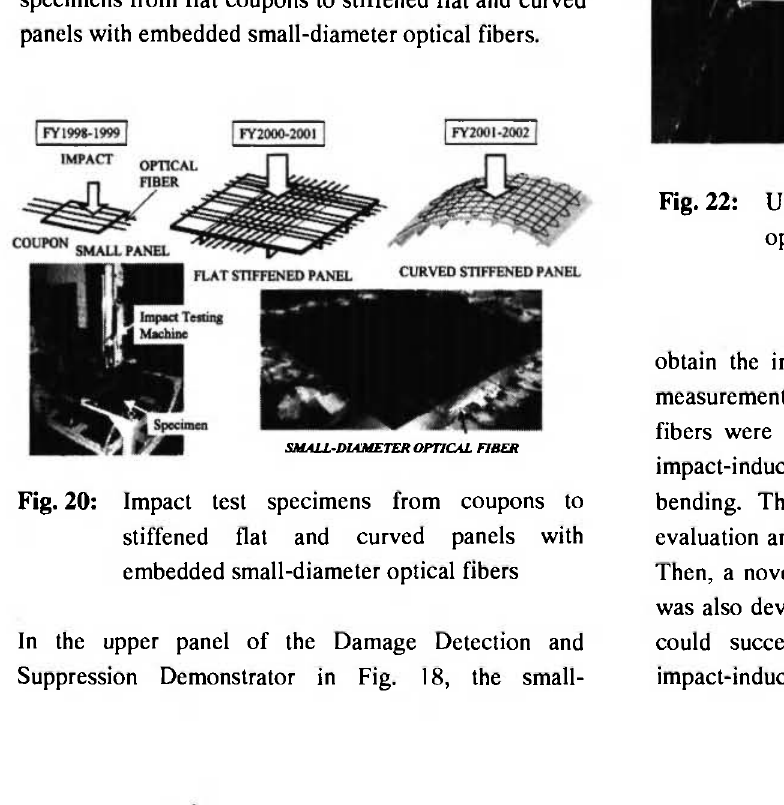
sensors was conducted as a collaborative work between the University of Tokyo and Kawasaki Heavy Industries. Monitoring of the impact load on composite laminates was successfully made with embedded multi- mode small-diameter optical fibers /18, 19/. The bending loss was observed only during impact loading. The maximum magnitude of optical loss was found to be proportional to that of the impact load. Several small- diaineter FBG sensors were also used to obtain the impact location through the dynamic strain measurement. Figure 20 shows the impact test specimens from flat coupons to stiffened flat and curved panels with embedded small-diameter optical fibers.